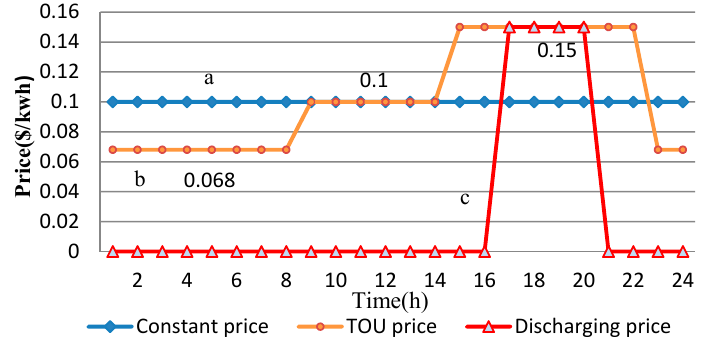
Figure 4. Three different electricity price profiles.